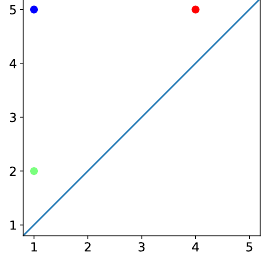
Figure 6. The proposed tracking model applied to the sequence of four simplicial complexes in Figure 5 is displayed. Each 0-simplex is uniquely coloured according to the object to which it corresponds.